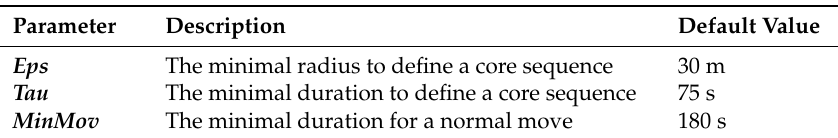
Table 3. Three key parameters of